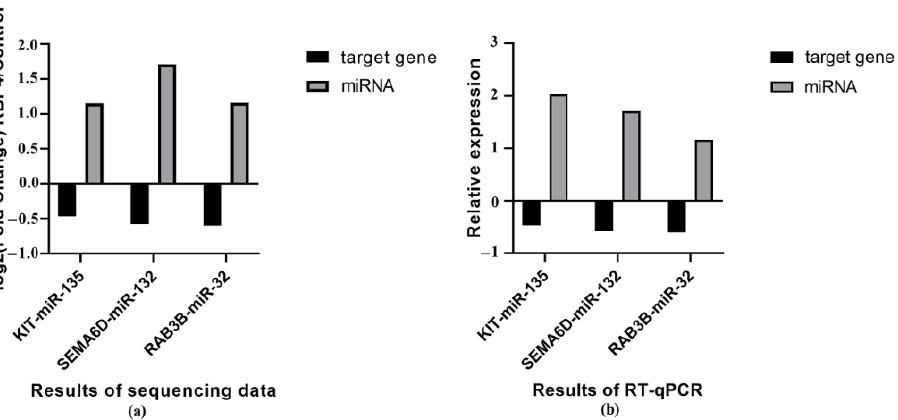
Figure 5. Sequencing and RT-qPCR analyses of the DEmiRNAs and their predicted target genes in the RBP4 and control groups ( n = 3 replicates per group). ( a ) Results of sequencing. ( b ) Results of RT-qPCR.